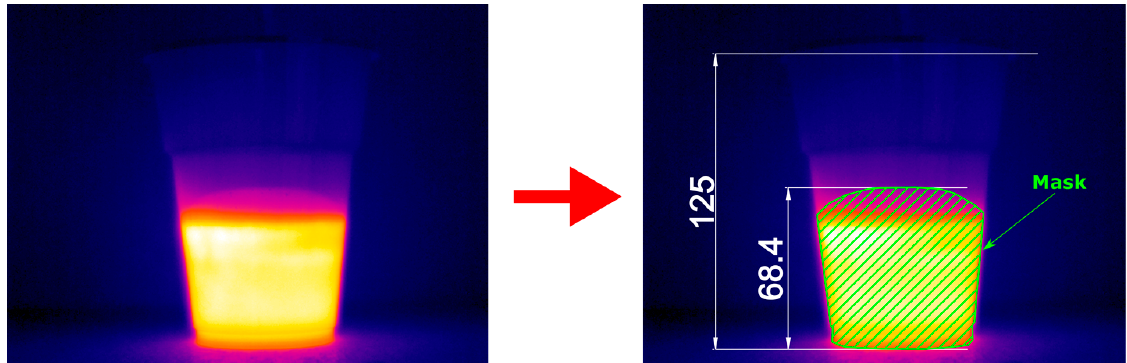
Figure 2. Scheme of the foam area based on the thermal image.